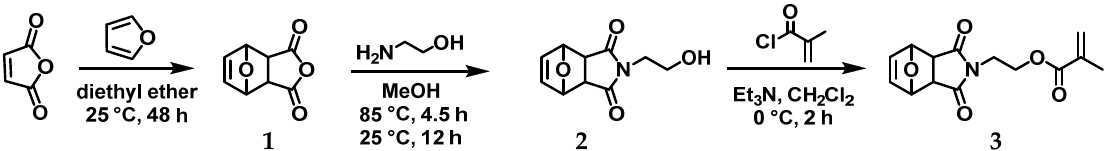
Figure 4. Reaction scheme of the furan protected maleimide methacrylate.